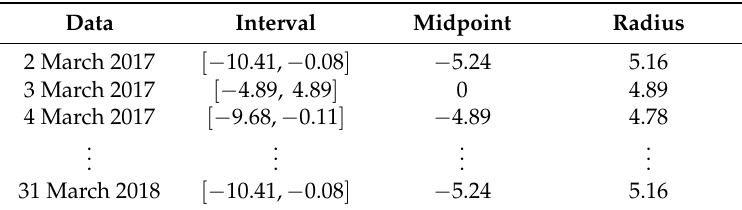
Table 3. Midpoint–radius form of